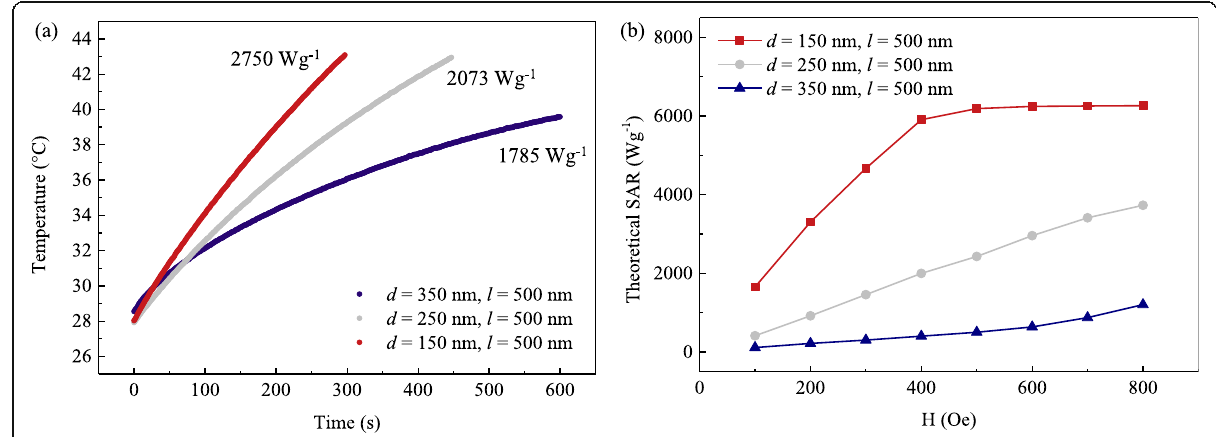
Fig. 5 a Temperature-time curves of NiFe MNPs under a magnetic field strength of 47.8 kAm − 1 (600 Oe) and frequency of 360 kHz, while the MNP length d increased from 150 to 350 nm. b Theoretical SAR values for NiFe MNPs, with d = 150 – 350 nm and l = 500